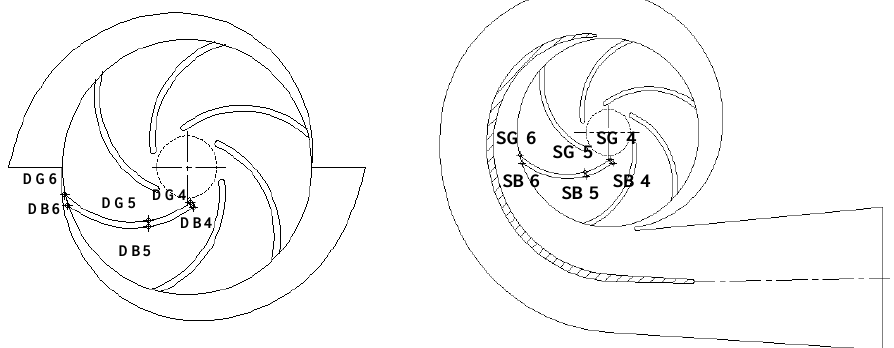
Figure 5. Monitoring point for impeller pressure fluctuations.